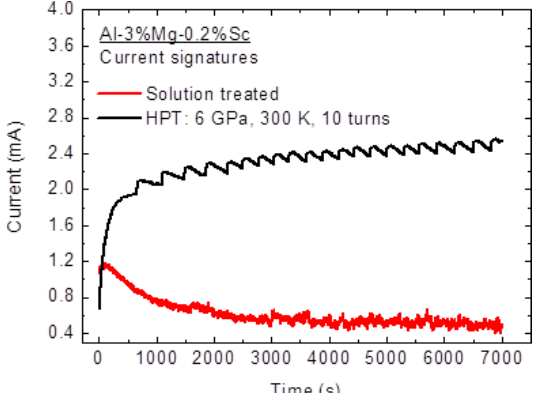
Figure 9. Current signatures recorded during chronoamperometric measurements of solution treated and HPT-processed alloys in